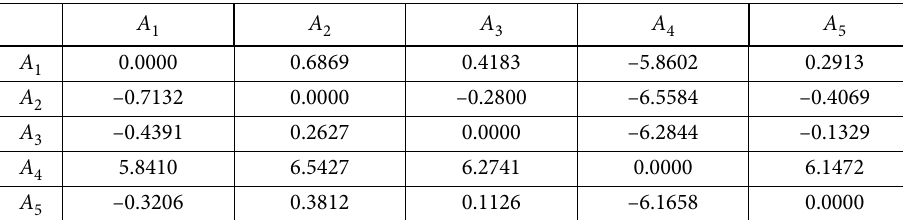
Table 11. Relative assessment matrix